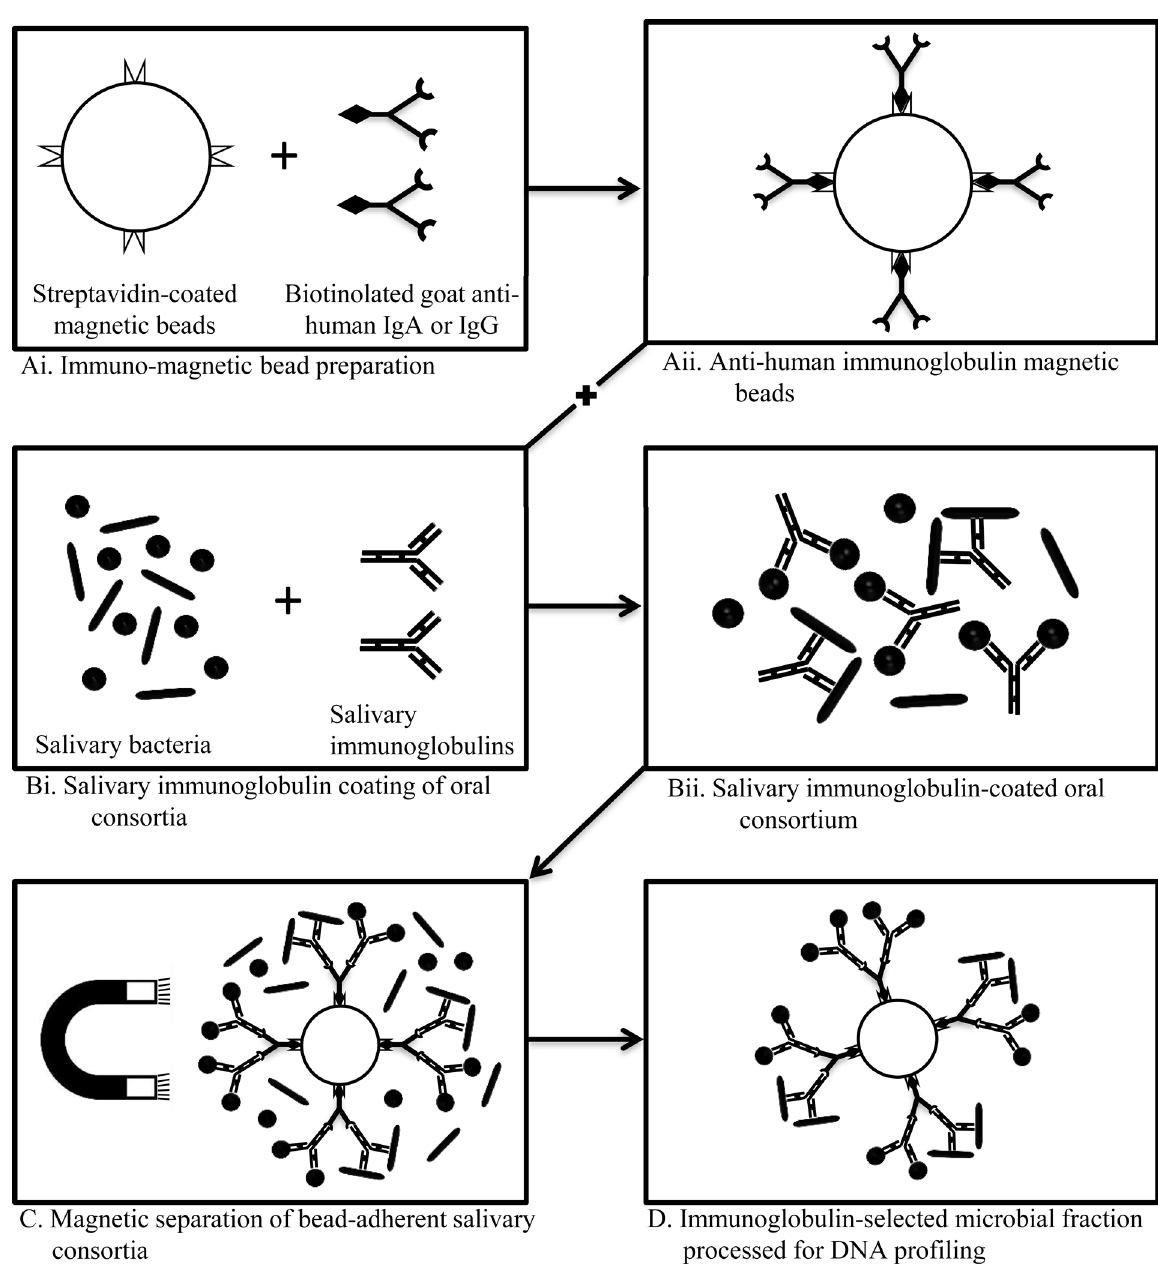
Fig 1. Schematic representation of the procedure for separation of salivary immunoglobulin recognized salivary consortia. (A) preparation of isotype specific magnetic beads; (B) coating of salivary consortia with immunoglobulins; (C) separation of immunoglobulin-recognized microbial consortia from complete oral consortium using magnetic bead separation; and (D) magnetic bead-adherent bacteria remaining after washing the non-adherent fraction.